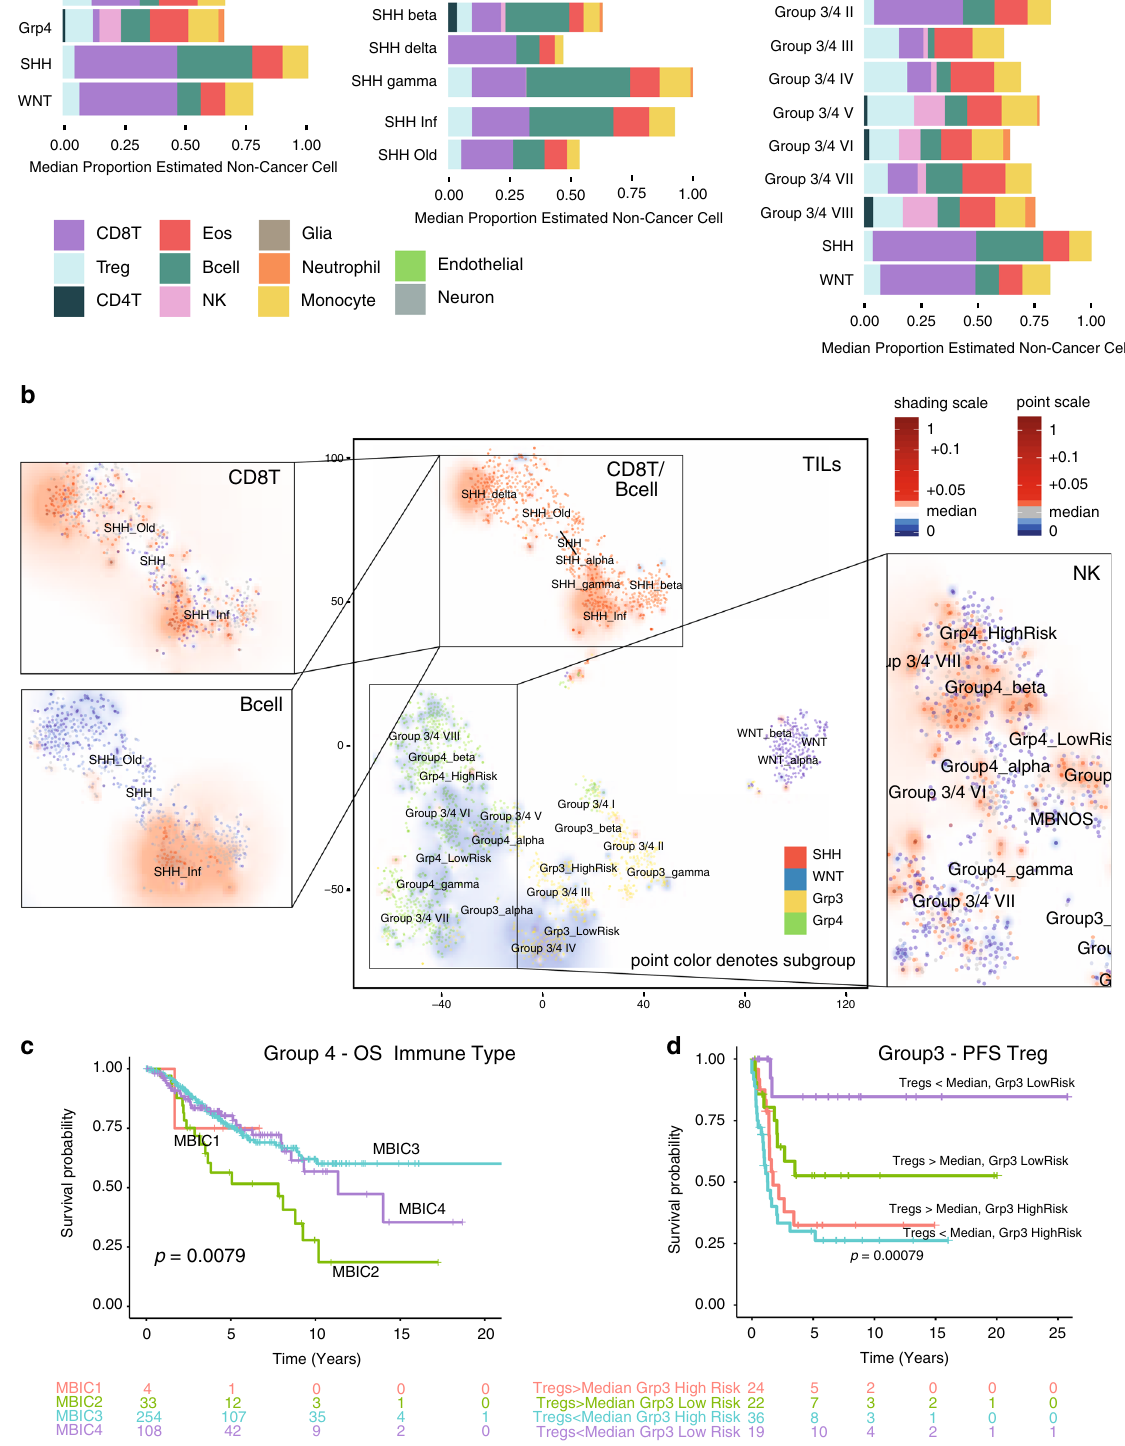
all MRT, and have relatively high proportion of neutrophils and monocytes, respectively. Both clusters contain a disproportionate number of ECRT and ATRT-TYR ( χ 2 = 48.218, p < 0.001) (Supplementary Fig. 8A). MRT IC4 constitutes 32% (74/229) of all MRT and is characterized by a relatively high proportion of CD8T and relatively low in fi ltration of other immune cell